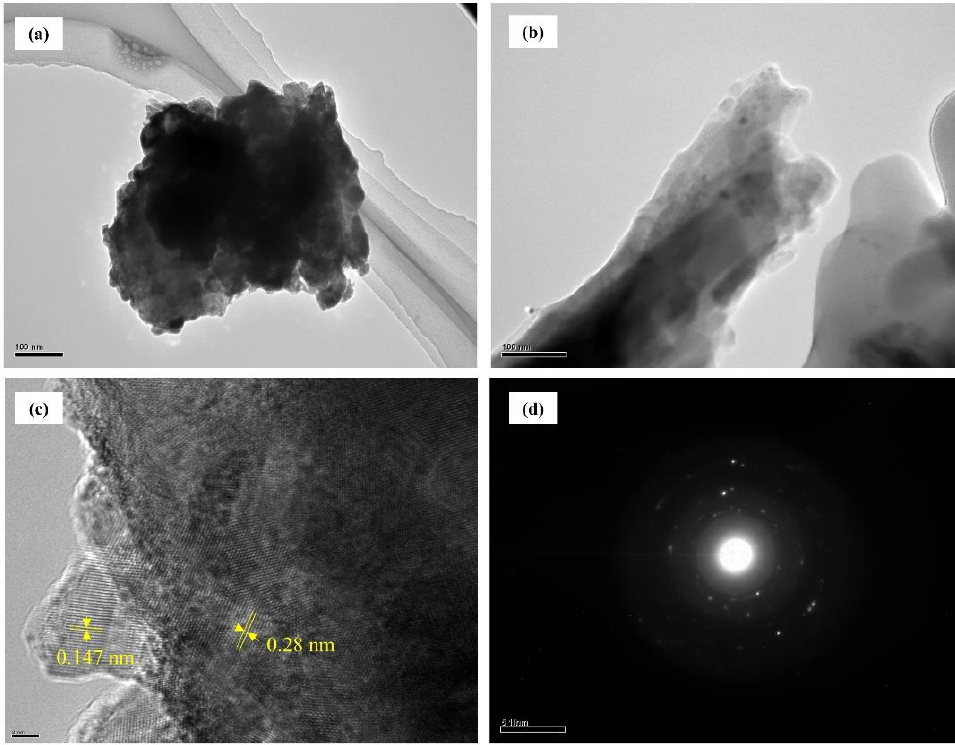
Figure 6. ( a , b ) TEM images; ( c ) HRTEM image; ( d ) SAED pattern of the synthesized PFSS.